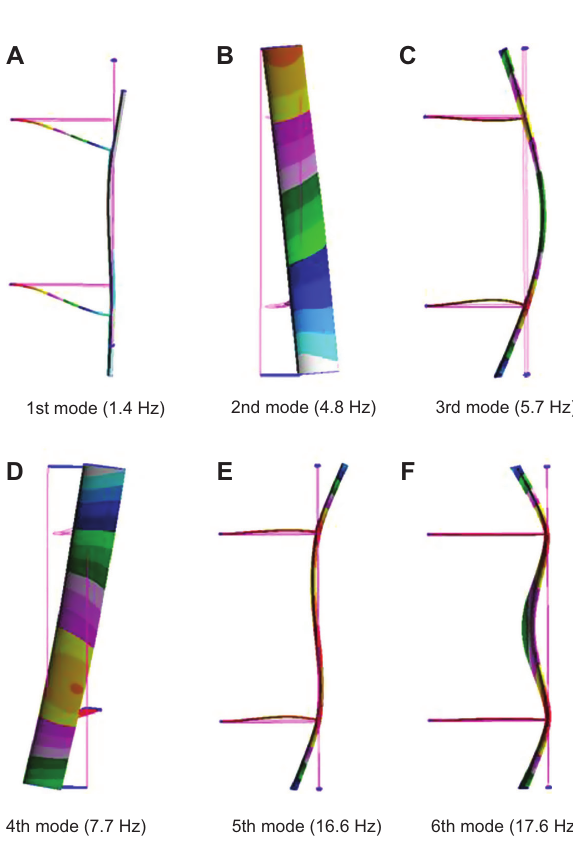
Figure 11 Natural vibration mode shapes and frequencies.